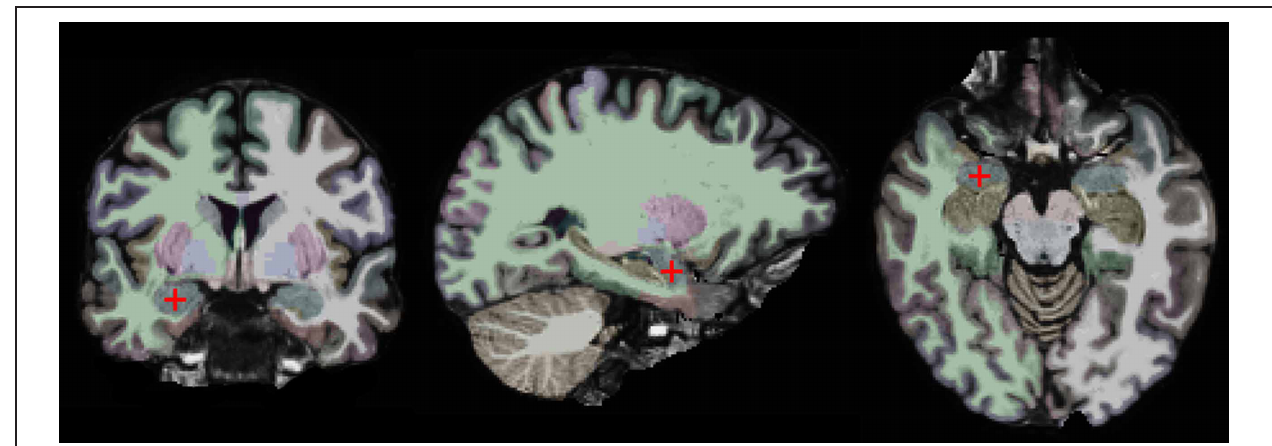
FIGURE 1 | Coronal, sagittal, and horizontal views of the brain of one study participant. The right amygdala is marked by a red crosshair and colored in blue. The other colors indicate different brain regions as automatically segmented by the FreeSurfer software.